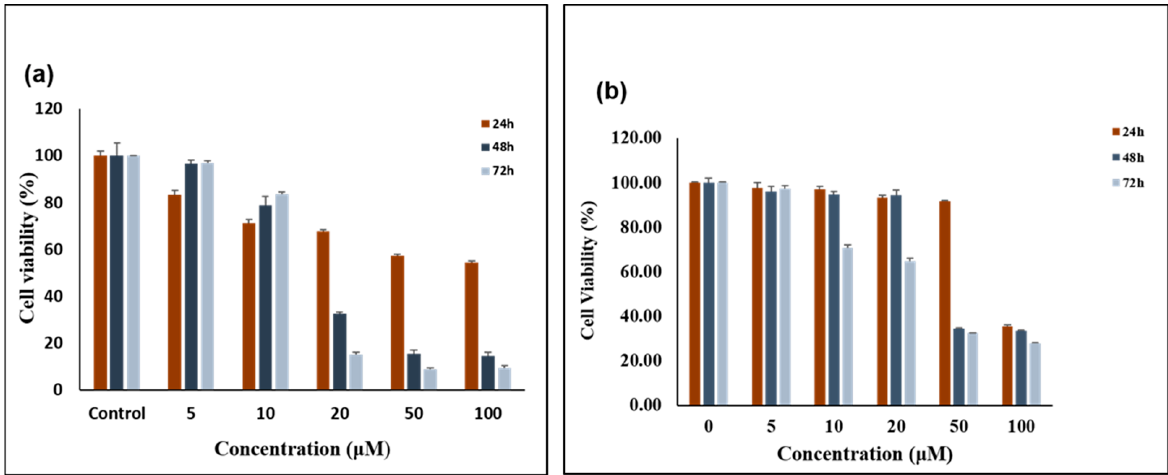
Figure 9. Cytotoxic effect of LC-ZnO/OF at different concentrations in A549 ( a , b ) AGS cells at 24, 48, and 72 h. Results were presented as a percentage of cell growth inhibition compared with the control.